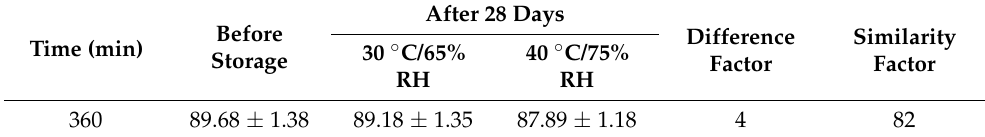
Table 8. Difference and similarity factors of dissolution profile of optimized formulation.